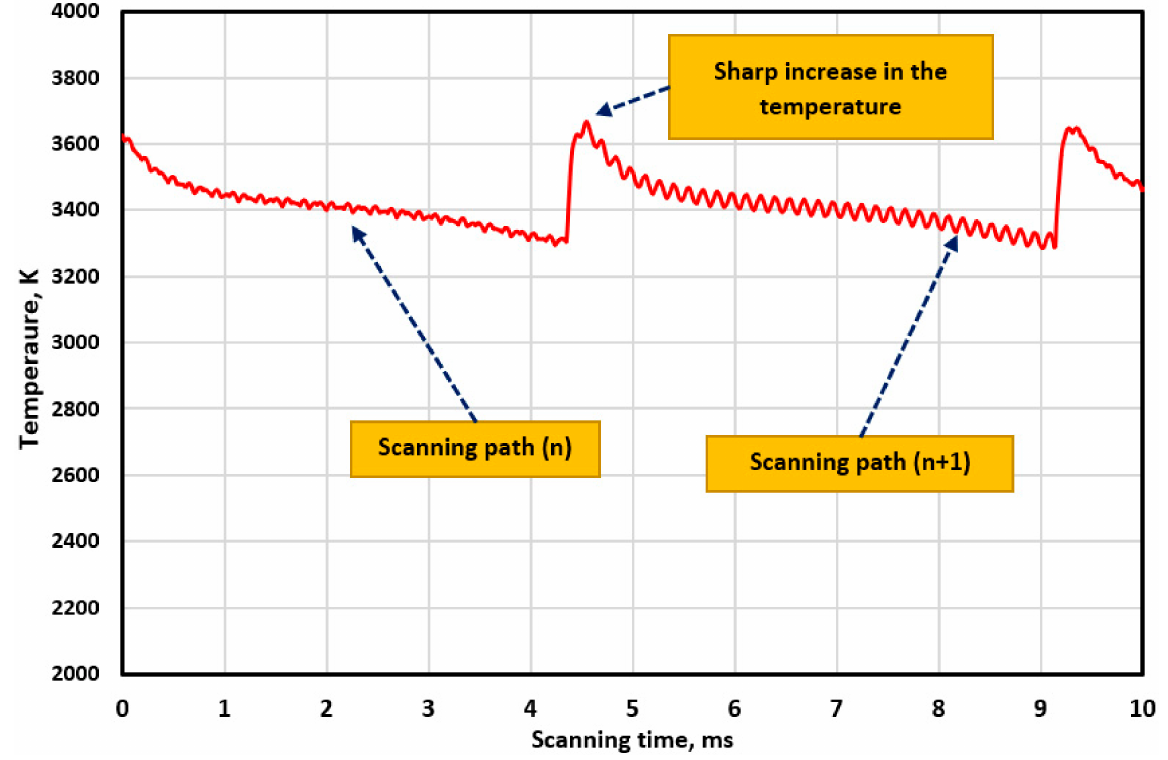
Figure 16. Focused view for two scanning paths using the inclined zigzag strategy.